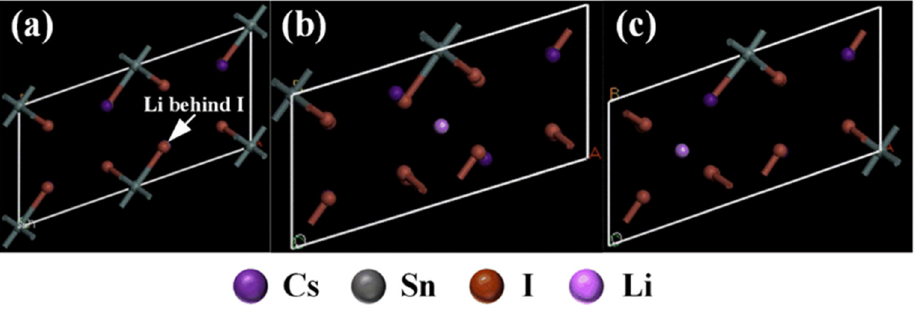
Figure 2. Position of Li + ions in Cs 2 SnI 6 lattice, ( a ) Li + replaced Cs + , ( b ) Li + interstitial site 1 and ( c ) Li + interstitial site 2. Table 1. Energy difference calculation results of Li + ions doped Cs 2 SnI 6 . Doping Position